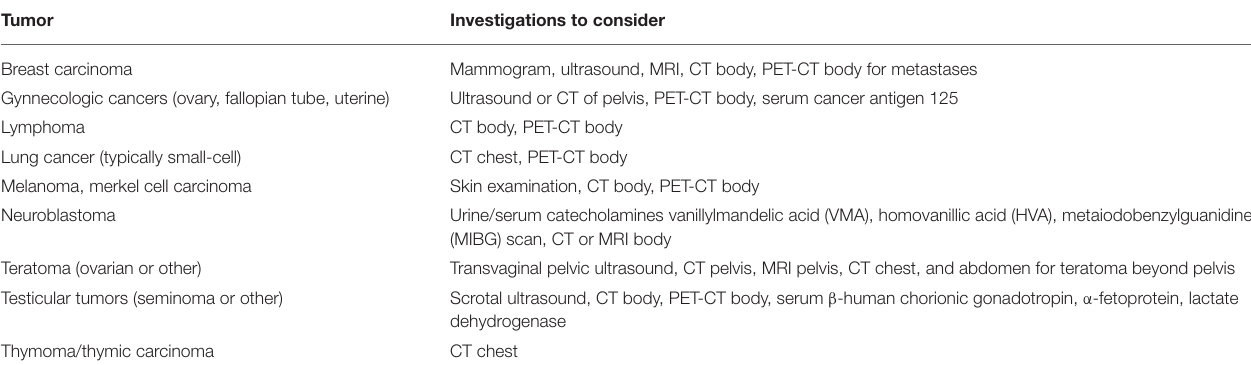
TABLE 3 | Cancer investigations to consider in patients with neural autoantibodies with a high likelihood of an accompanying cancer. Tumor